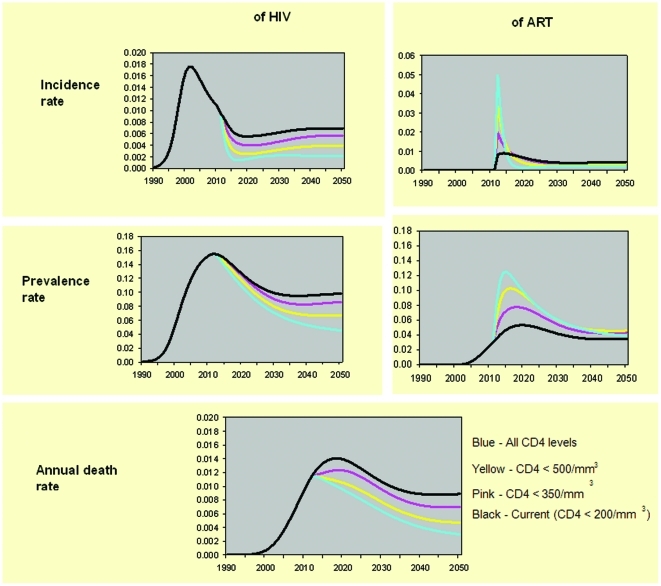
Key epidemic indicators by ART scenario, over time, enhanced prevention scenario to 2050.This figure presents key epidemic results. The adult population is the denominator. “Blue” is all CD4 levels, “Yellow” is <500/mm3, “Pink” is <350/mm3, and “Black” is current <200/mm3. The “Incidence rate” graphs show that the rate of new HIV infections drops most sharply with higher ART use due to more inclusive CD4 criteria. The “Prevalence Rate” graphs show a similar but more gradual decline in HIV prevalence with more ART, and also show that differences in ART use in the short term converge over time due to averted infections The “Annual death rate” graph highlights the benefit of expanded ART on death rates.